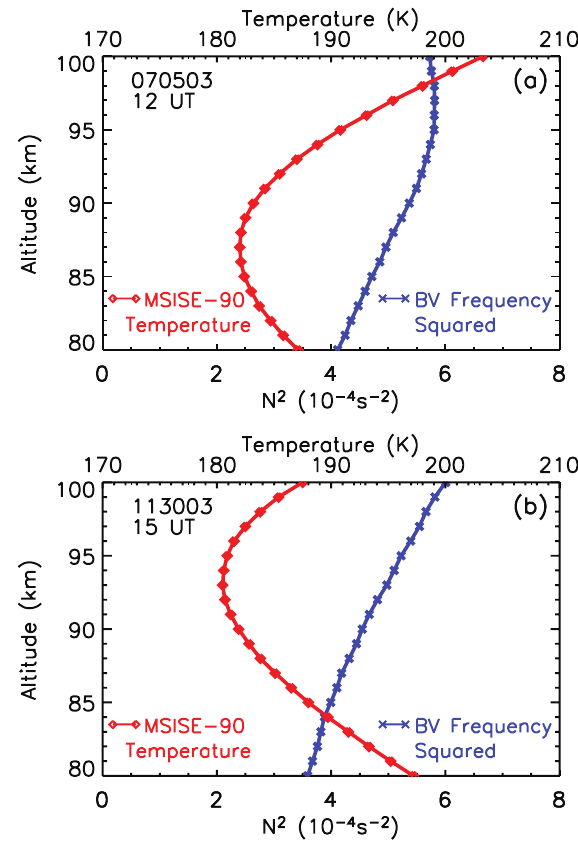
Fig. 4. The plots depict the MSISE-90 model temperature (red) and Brunt-V¨ais¨al¨a frequency squared (blue) profiles for (a) 5 July 2003 ducted wave event at 12:00UT, and (b) 30 November 2003 evanescent event at